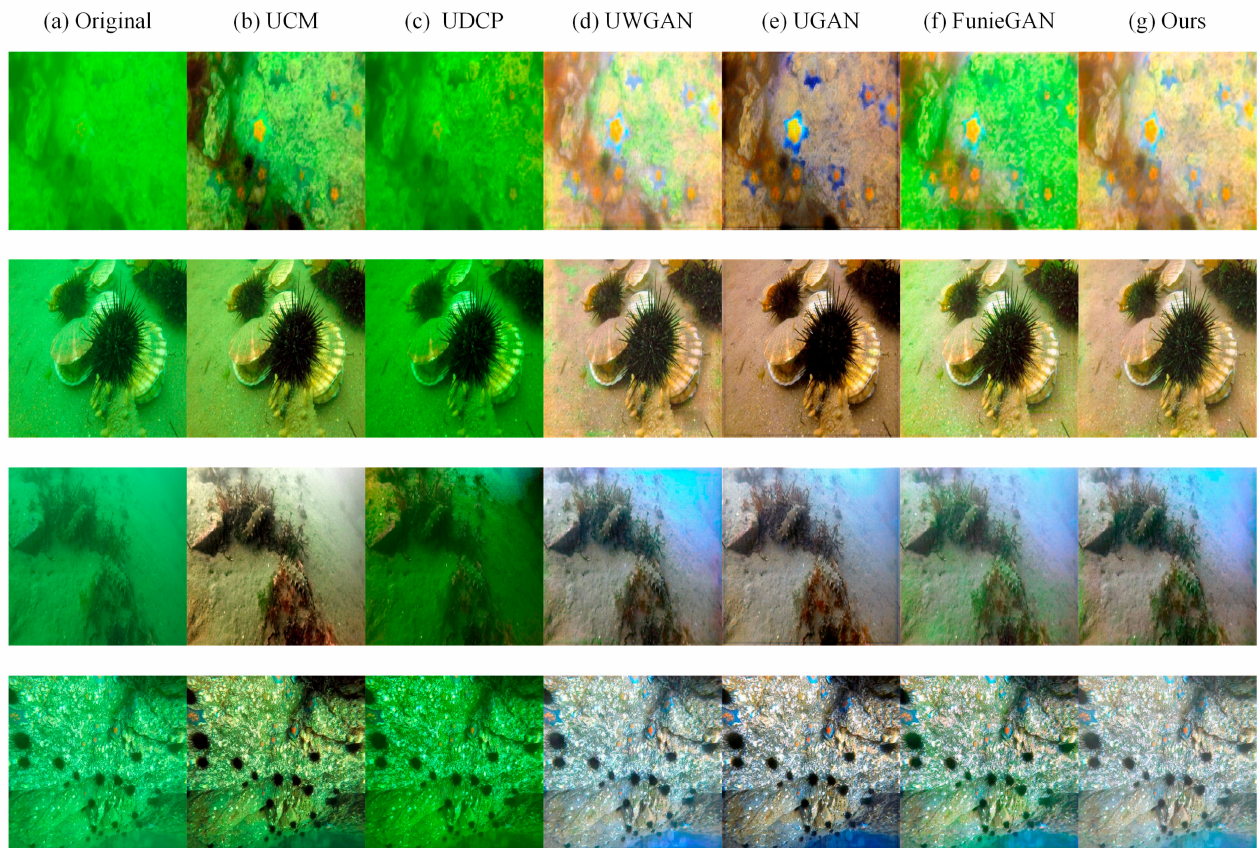
Figure 7. Qualitative comparisons for samples from real underwater datasets. ( a ) Real underwater images. ( b ) Results of UCM. ( c ) Results of UDCP. ( d ) Results of Unet3. ( e ) Results of UGAN. ( f ) Results of FunieGAN. ( g ) Our